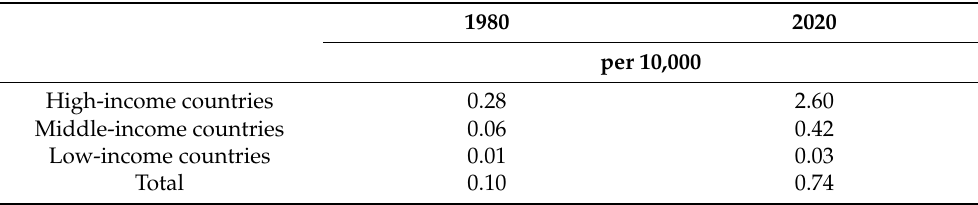
Table 1. Number of centenarians based on the income of the various